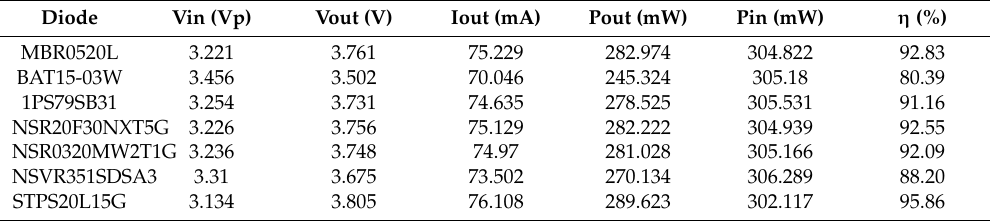
Table 7. Comparative results between different diodes at 1 sun and 60 ◦